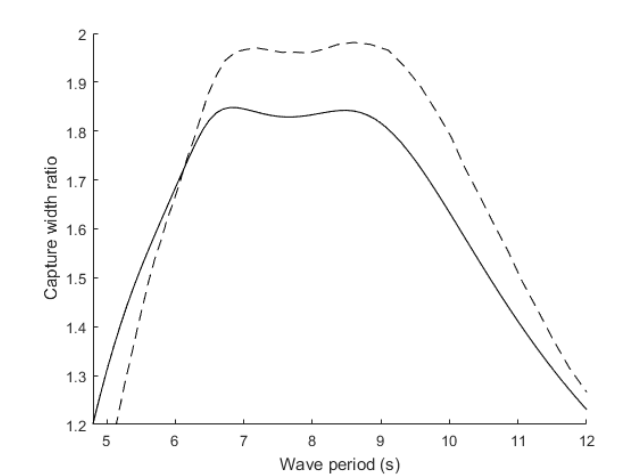
Fig. 5. Efficiency of single duck in 40° oblique waves, 1m wave amplitude, with motion constraints. Dotted line: Result from [9].